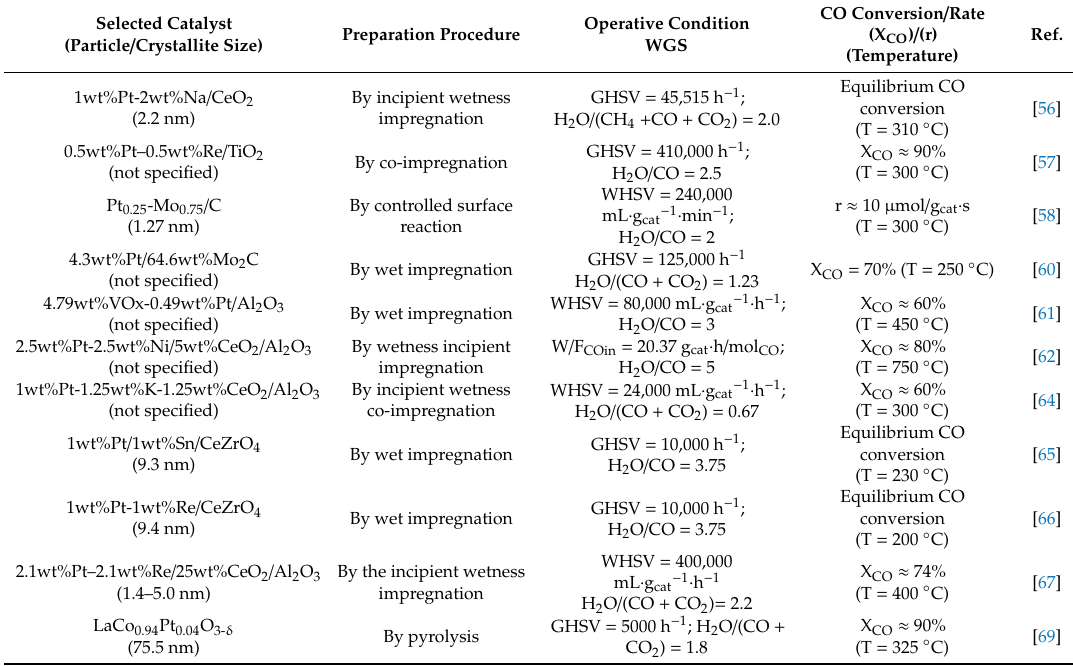
Table3. SummaryofthemaincatalyticresultsfromthearticlesreportedinSection2.3.1andSection2.3.2. Selected Catalyst (Particle / Crystallite